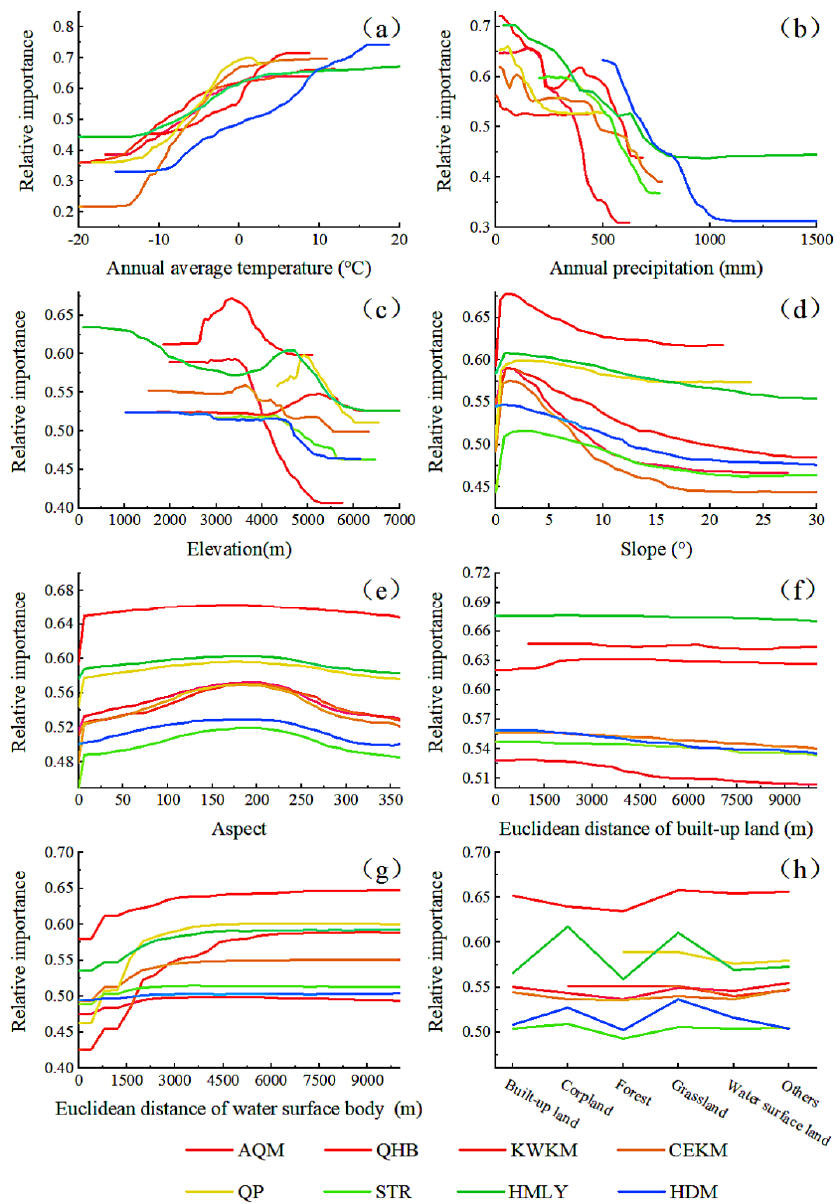
Figure 15. Relative importance of driving factors in different geomorphic regions. ( a ) Annual average temperature; ( b ) Annual precipitation; ( c ) Elevation; ( d ) Slope; ( e ) Aspect; ( f ) Euclidean distance of built-up land; ( g ) Euclidean distance of water surface body; ( h ) Land use and Land cover.